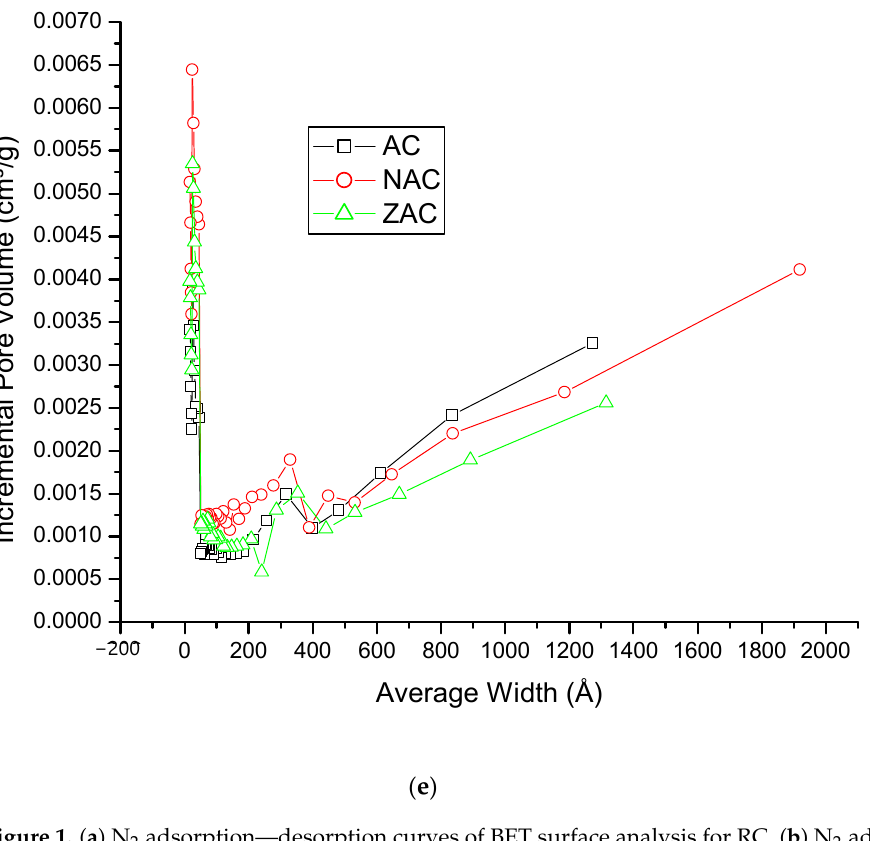
Figure 1. ( a ) N 2 adsorption—desorption curves of BET surface analysis for RC. ( b ) N 2 adsorption–desorption curves of BET surface analysis for AC. ( b ) N 2 adsorption—desorption curves of BET surface analysis for AC. ( c ) N 2 adsorption - desorption curves of BET surface analysis for NAC. ( d ) N 2 adsorption—desorption curves of BET surface analysis for ZAC. ( e ) The maximum pore volume of the prepared samples.